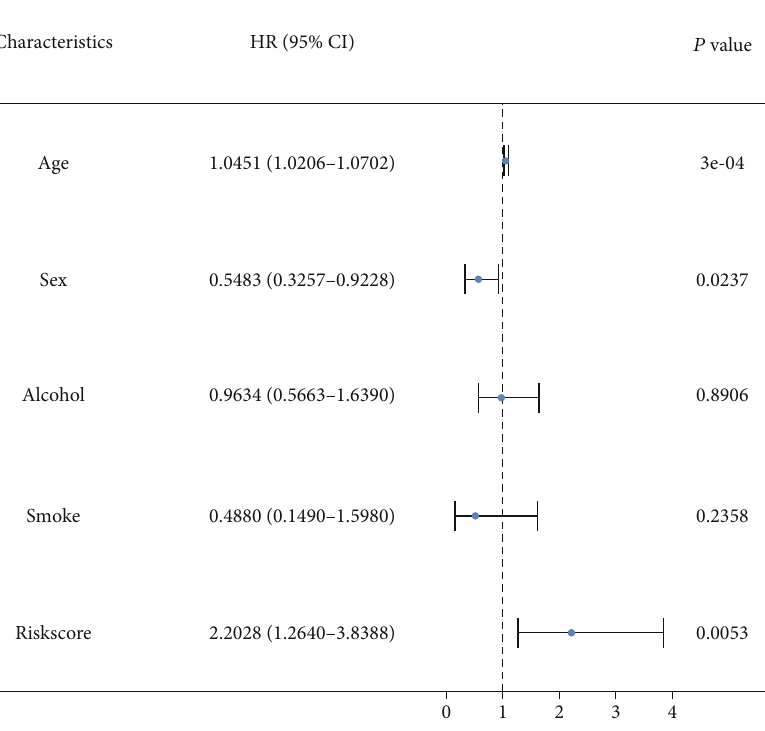
Figure 2: Forest plot for univariate Cox regression analysis.